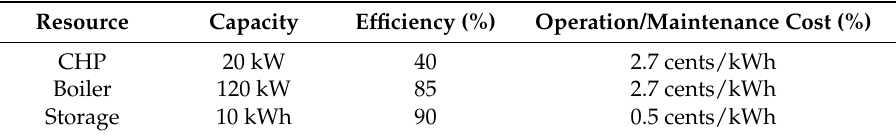
Table 2. Technical parameters of distributed energy resources (DERs).